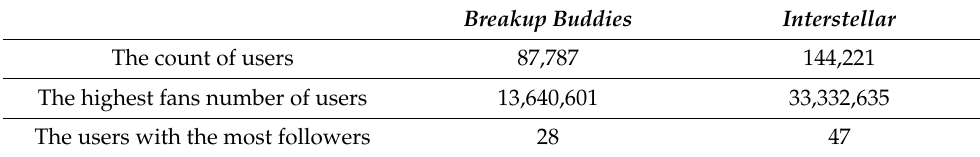
Table 4. Statistics of users related to the